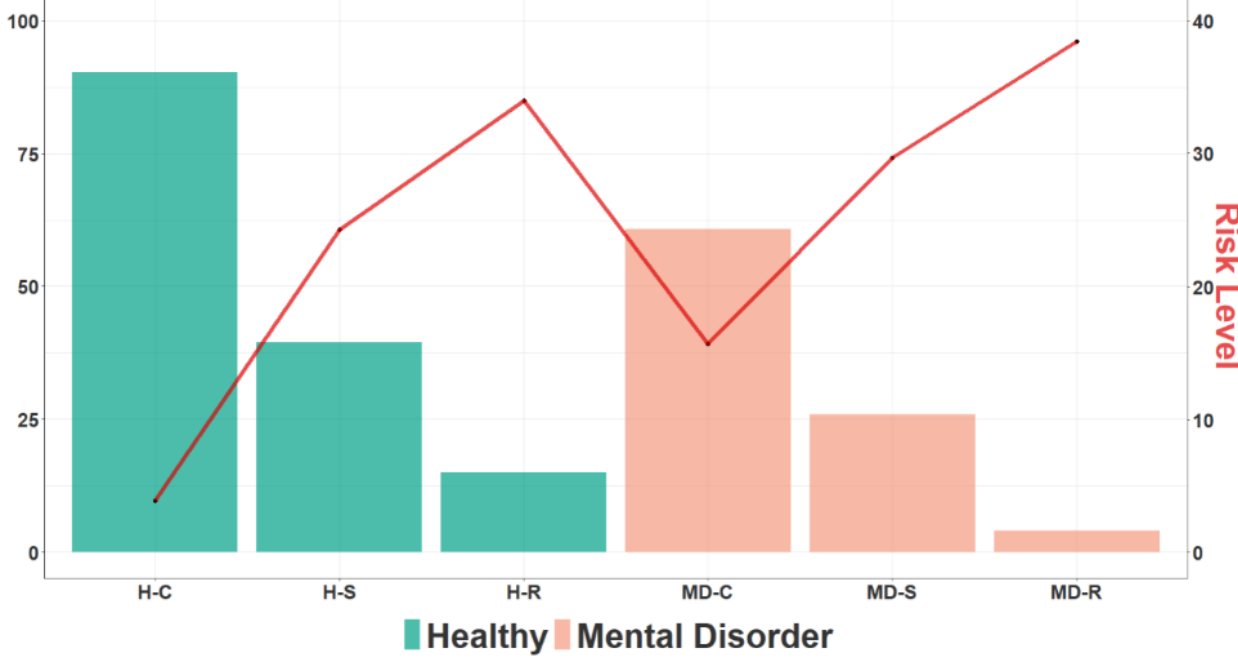
Figure 12. Results of the integration of the R/H behaviour models (SVM) and the WHO model for Mental Disorder (MD, anxiety) conditions for the three Uses Cases for (SVM): UC1: Coordination, UC2: Stress, UC3: High risk. The line in “red” indicates the Risk Level.